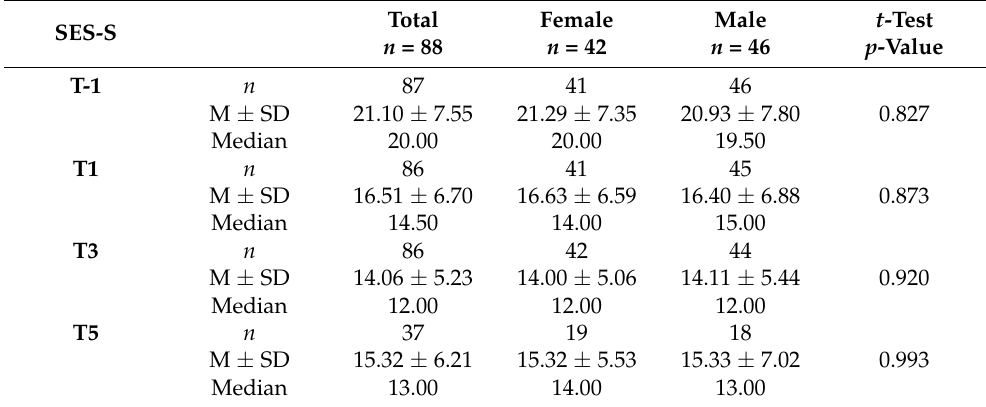
Table 3. Sensory pain perception (SES-S) from hospital admission (T-1) to day 5 after operation (T5). p -values of t -test comparisons between men and